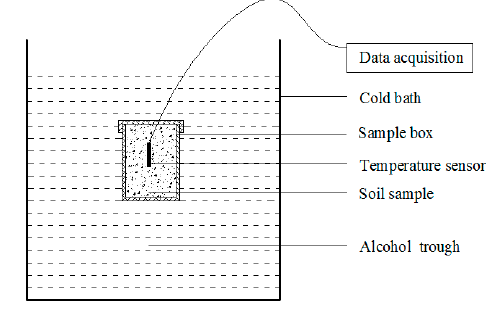
Figure 2. Test apparatus for freezing point measurement.